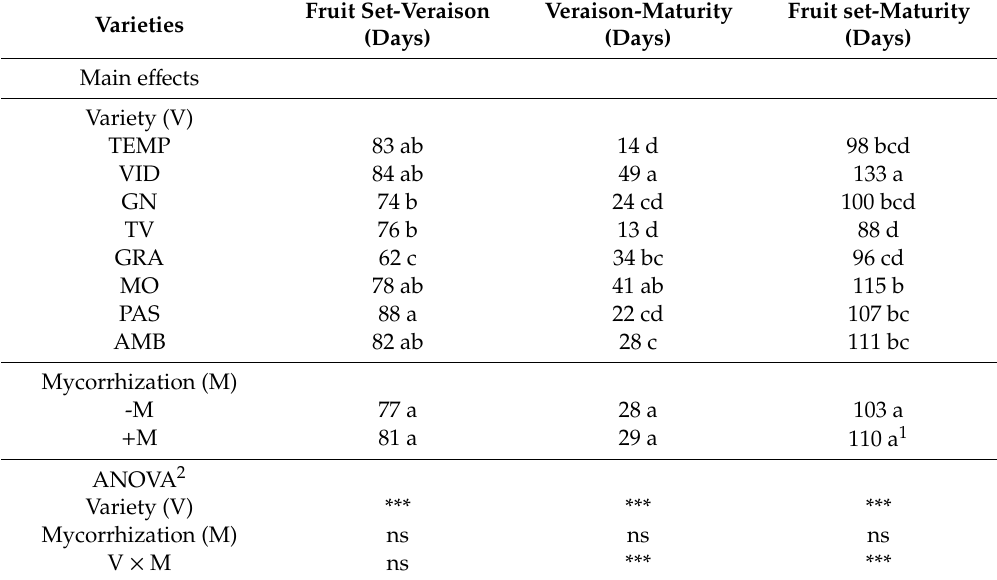
Table 2. Main e ff ects and their interaction on phenology from fruit-bearing cuttings of ancient grapevine varieties inoculated with arbuscular mycorrhizal fungi ( + M) or non-inoculated (-M). The variety labels can be found in Table